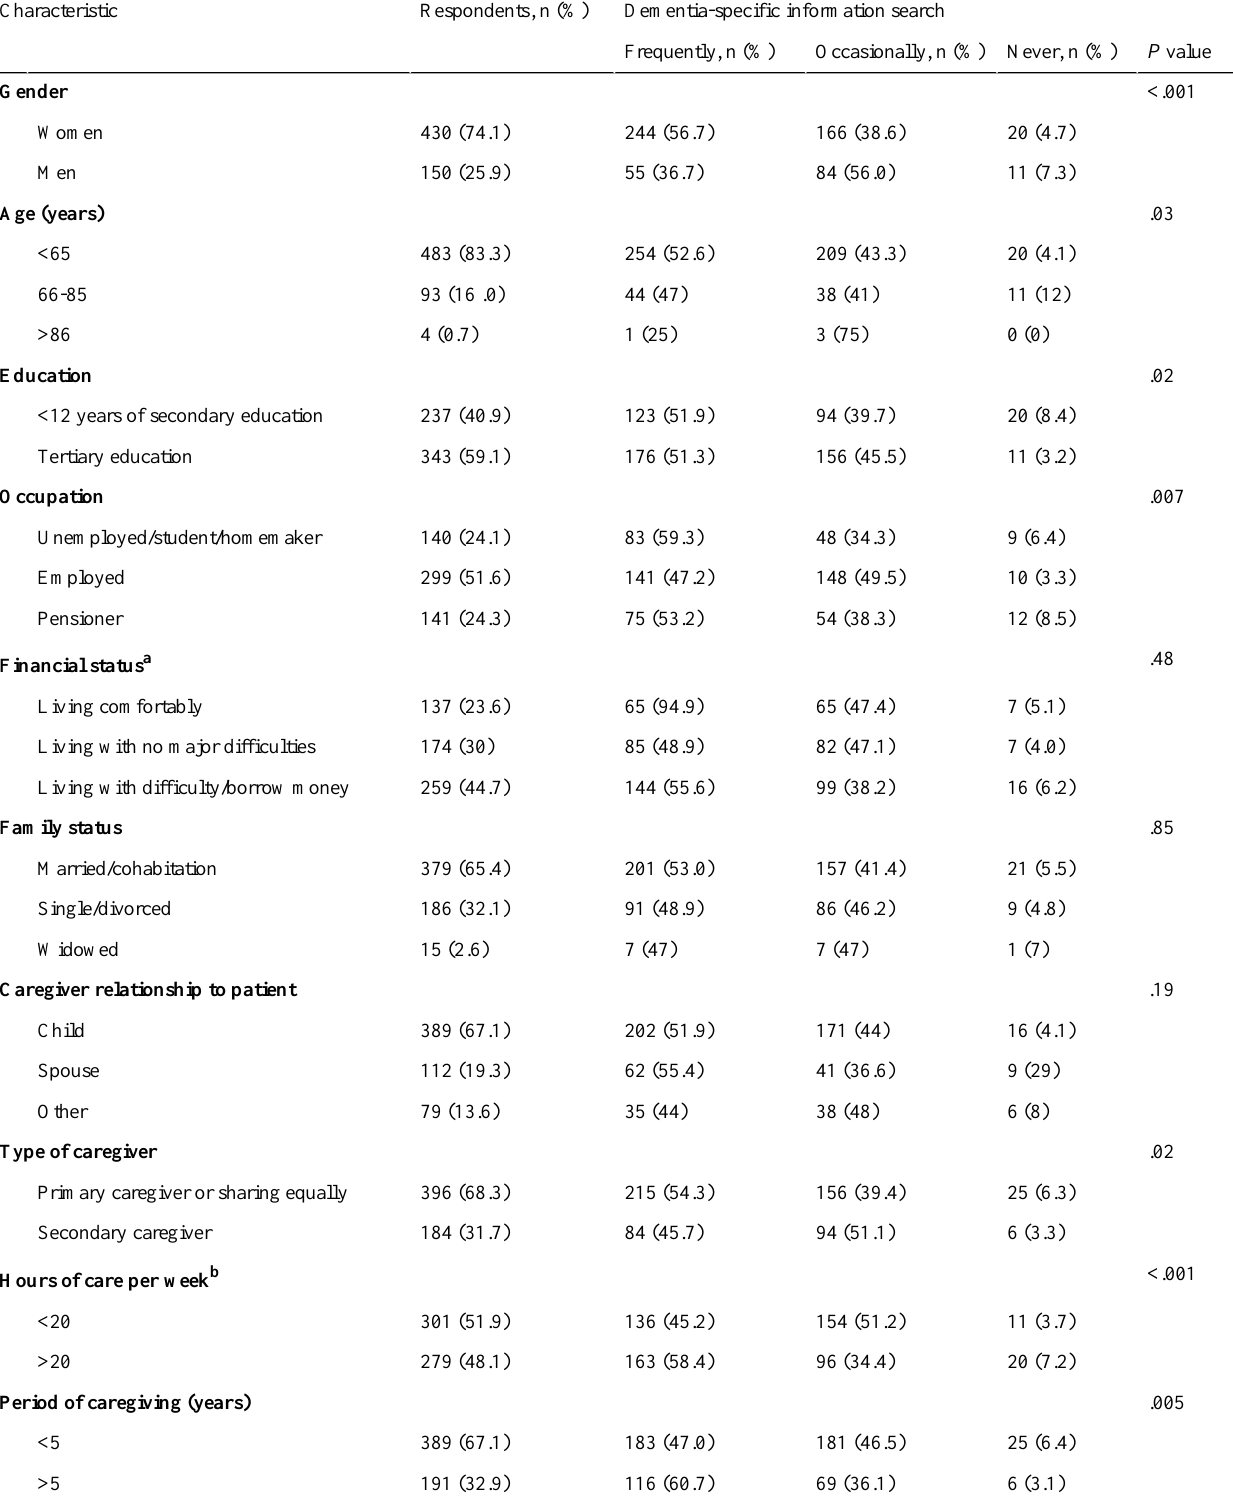
Table 1. Caregiver demographics and their association with dementia-specific information searching (N=580).